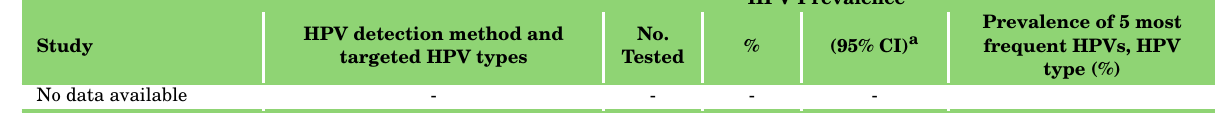
Table 26: Studies on HPV prevalence among cases of AIN2/3 in India HPV detection method and Study targeted HPV